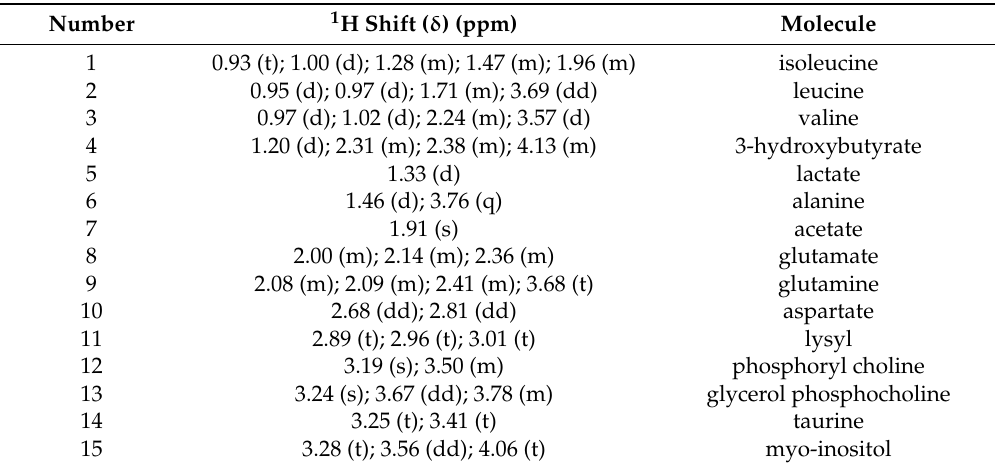
Figure 3. Proton 1D spectra of methanol treated ( a ) and untreated ( b , c ) neurosphere samples. All experiments were recorded by Carr–Purcell–Meiboom–Gill (CPMG) sequence with the total echo delay of 1.0 ms. The experimental times were from 15 to 20 h. The asterisk (*) denotes the lipid peak. The detailed assignments are given in Table 1. Table 1. Proton chemical shift assignments of metabolites from 1D spectra of neurosphere samples from Figure 3 [22].